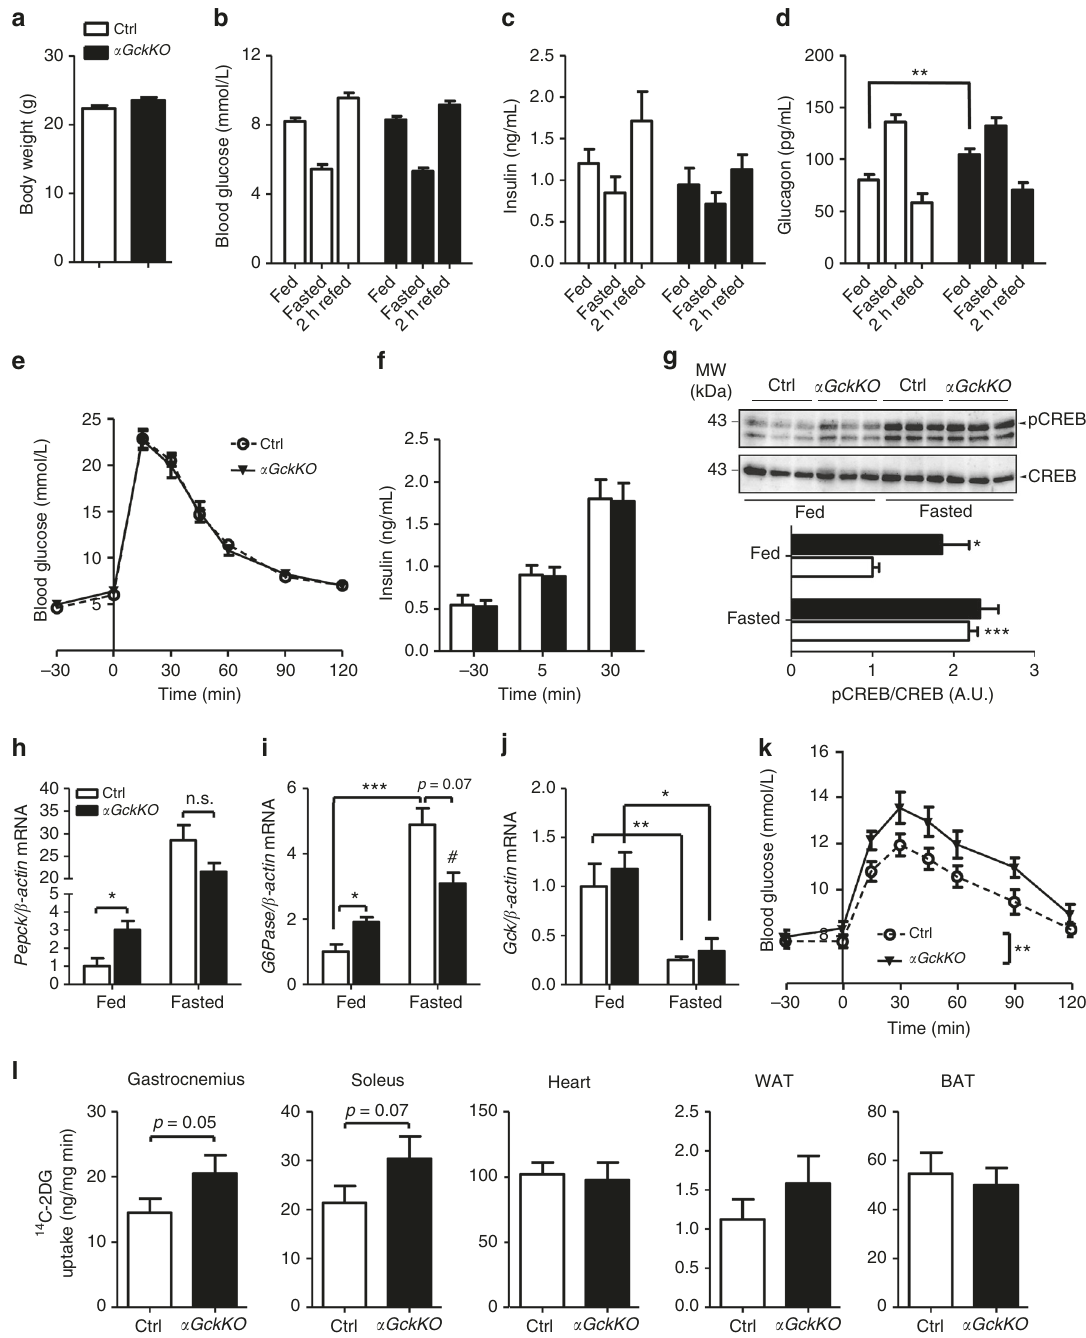
Fig. 3 Increased hepatic glucose production in α GckKO mice. a Body weight, b Blood glucose, c Plasma insulin, and d Plasma glucagon. a – d 20 week-old female mice. n = 19 Ctrl and n = 27 α GckKO mice; ** p < 0.01. Student ’ s t -test. See also Supplementary Fig. 5. e Intra-peritoneal glucose tolerance test. n = 13 mice for each genotype. f Plasma insulin at the indicated times before and after i.p. glucose injection. n = 13 mice for each genotype. g CREB and phosphorylated CREB in fed and fasted Ctrl and α GckKO mouse livers. See also Supplementary Fig. 8. h Pepck , i G6Pase and j Gck mRNA levels in the livers from fed and fasted Ctrl and α GckKO mice. h – j n = 4 – 5 per genotype; * p < 0.05, ** p < 0.01, *** p < 0.001, # p < 0.05 vs. Ctrl fed state; Student ’ s t -test. See also Supplementary Fig. 6 and Supplementary Table 1. k Pyruvate tolerance test. n = 11 mice per genotype; ** p < 0.01 (Two-way ANOVA). l 14 C-2DG uptake in the indicated tissues of Ctrl and α GckKO mice. n = 9 Ctrl and n = 10 α GckKO mice. * p < 0.05; Student ’ s t -test. Data are represented as mean ±